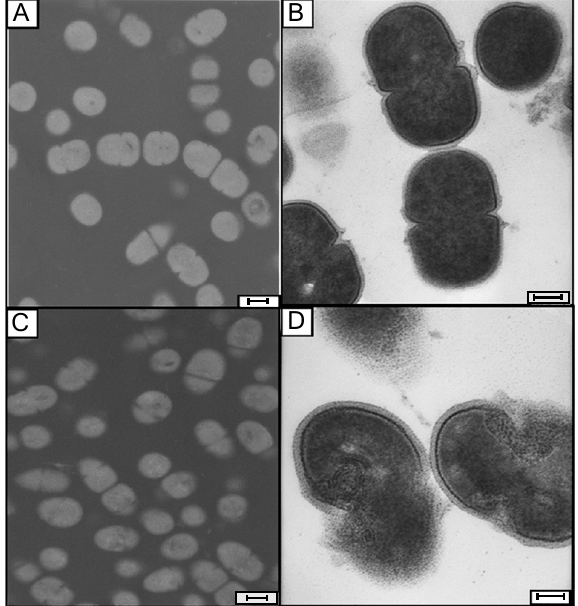
Figure 1. Electron micrographs showing the effect of toluene on Streptococcus mutans. A and B, Not-treated. C and D, Treated with toluene. Magnification bar: 300 nm in A and C, 100 nm in B and D. Notice severe injury of both cell wall and plasma mem- brane in most of the cells.